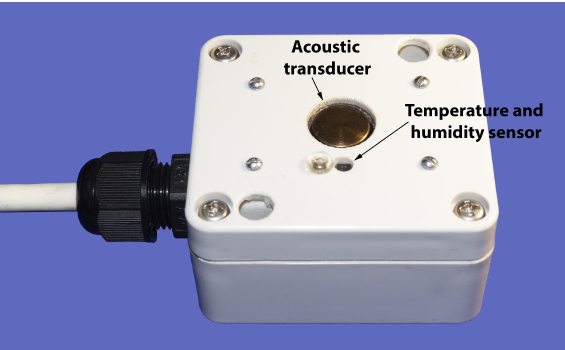
Figure 6. Snow thickness meter with integrated temperature and humidity sensor.